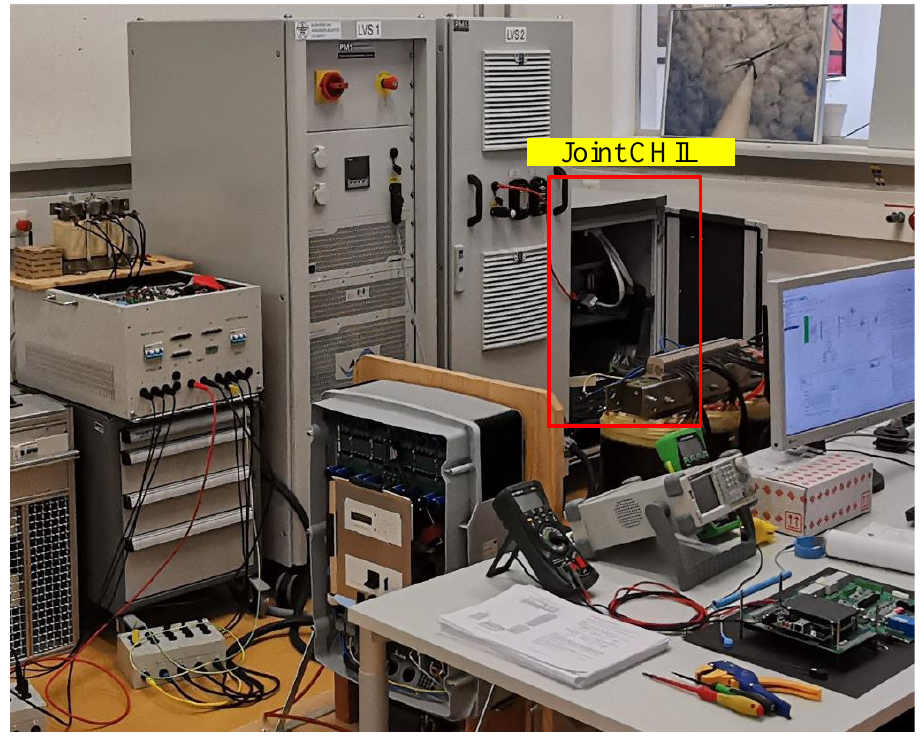
Figure 15. Photo of the laboratory where the joint CHIL system is installed in the rightmost equip- ment cabinet. equipment